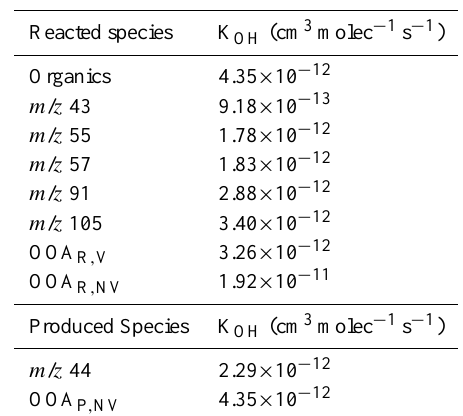
Table 1. Kinetic rate constants for total organics, selected m/z, and PMF factors with